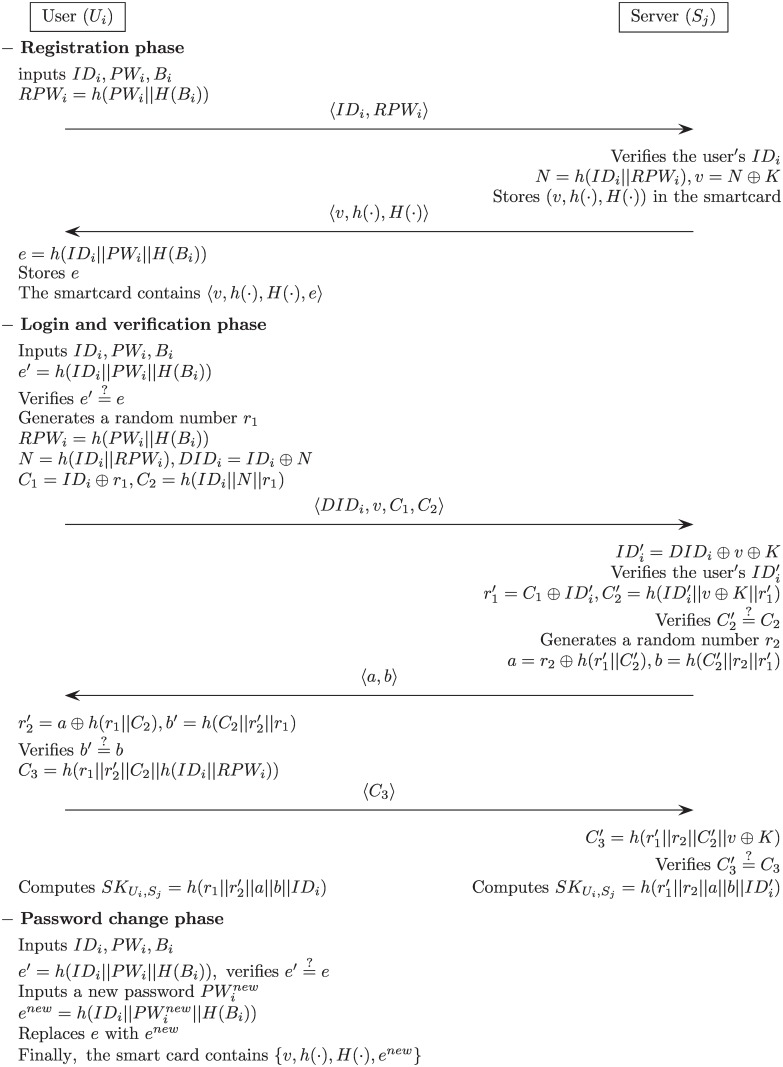
Our proposed scheme.